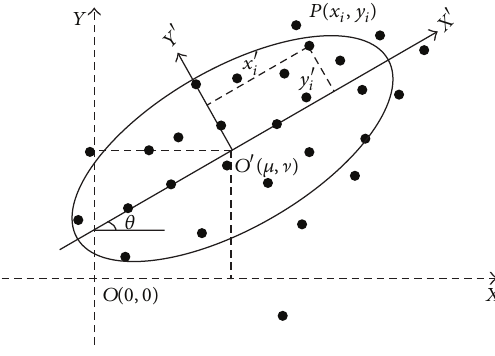
Figure 3: Standard deviational